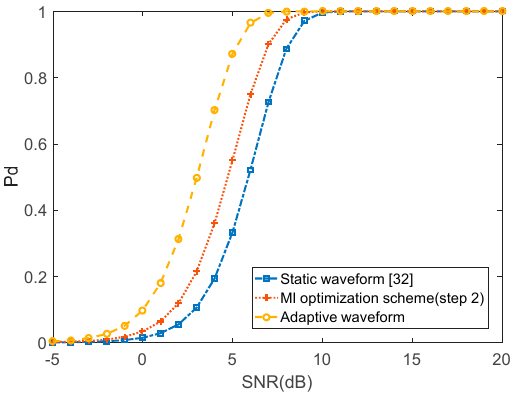
Figure 11. Probability of detection for adaptive waveform and static waveform.